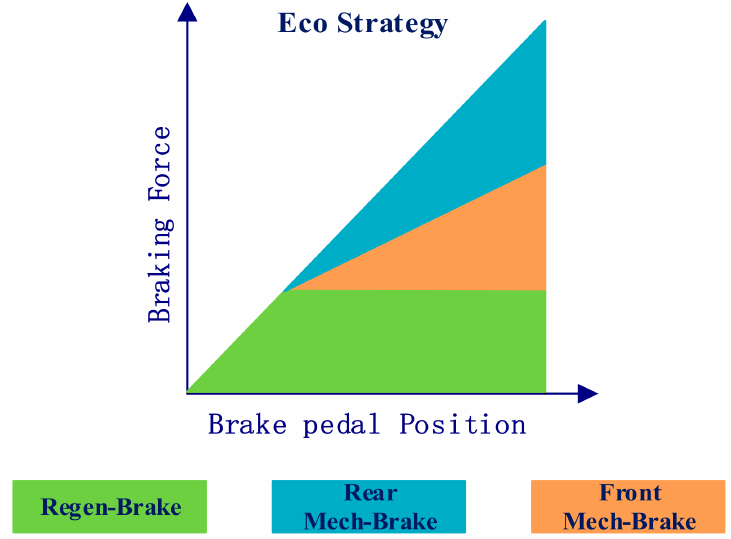
Figure 11. Braking force distribution of the ECO